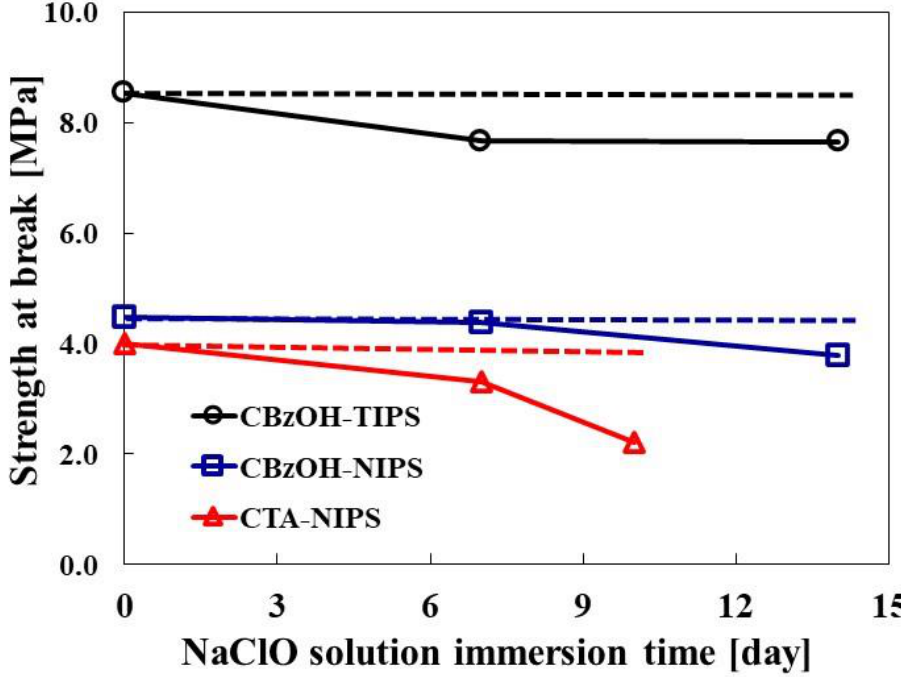
Figure 8. Immersion test of cellulose derivative in NaClO aqueous solution. (NaClO concentration: 2000 ppm).